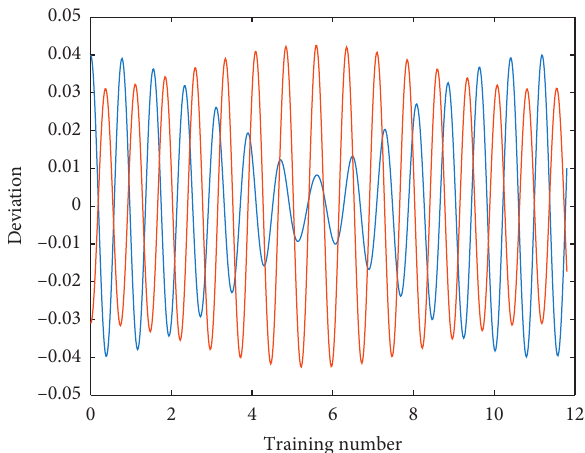
Figure 7: Deviation curve of VR training